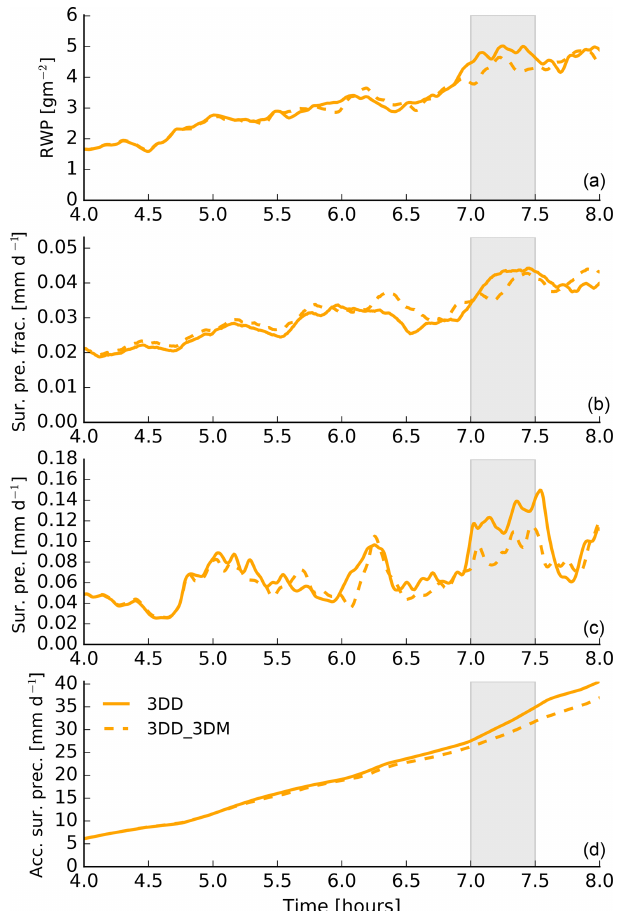
Figure 16. Similar to Fig. 15 but for 3 DD and 3 DD _3 DM . The gray shaded area shows the time period between 6.7 and 7.3h which is investigated in the further analysis.